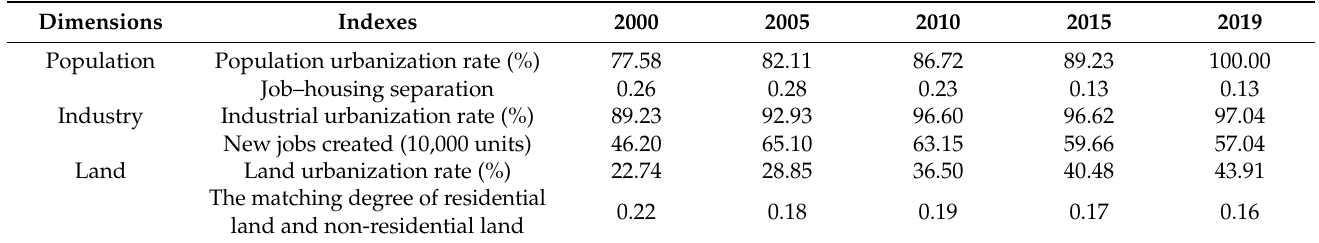
Table 7. Evaluation index data for the city–industry integrated development of Shanghai.